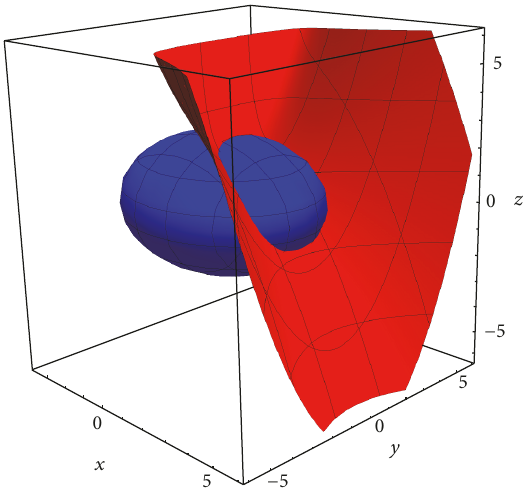
Figure 2: Periodic orbit ( 𝑘 = −1 , 𝑎 = 1 , 𝑀 = 2 , ℎ = ℎ 𝑒 𝑀 , and 𝑐 = 𝑐 𝑒 + 4 𝑀